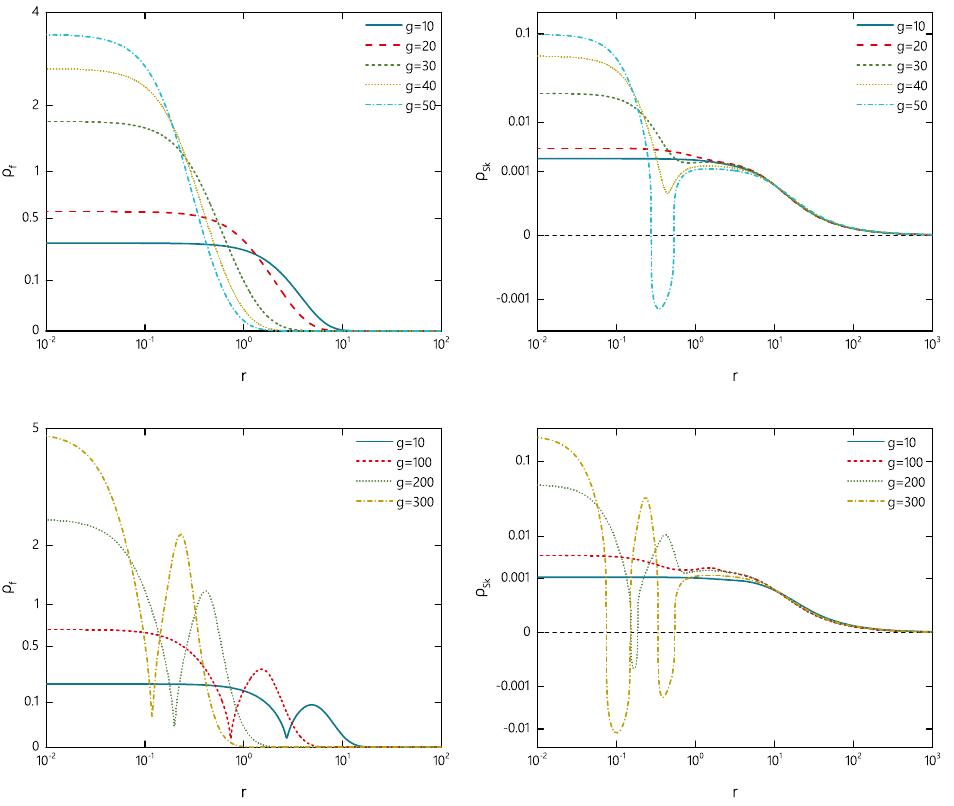
Figure 9 . Distributions of the fermionic density (left plots) of the localized modes A 0 (upper plots) and A 1 (bottom plots) and the topological density of the Skyrmion coupled to these modes (right plots) as functions of the radial coordinate r for some set of values of the coupling g at m = 0 and κ 0 =